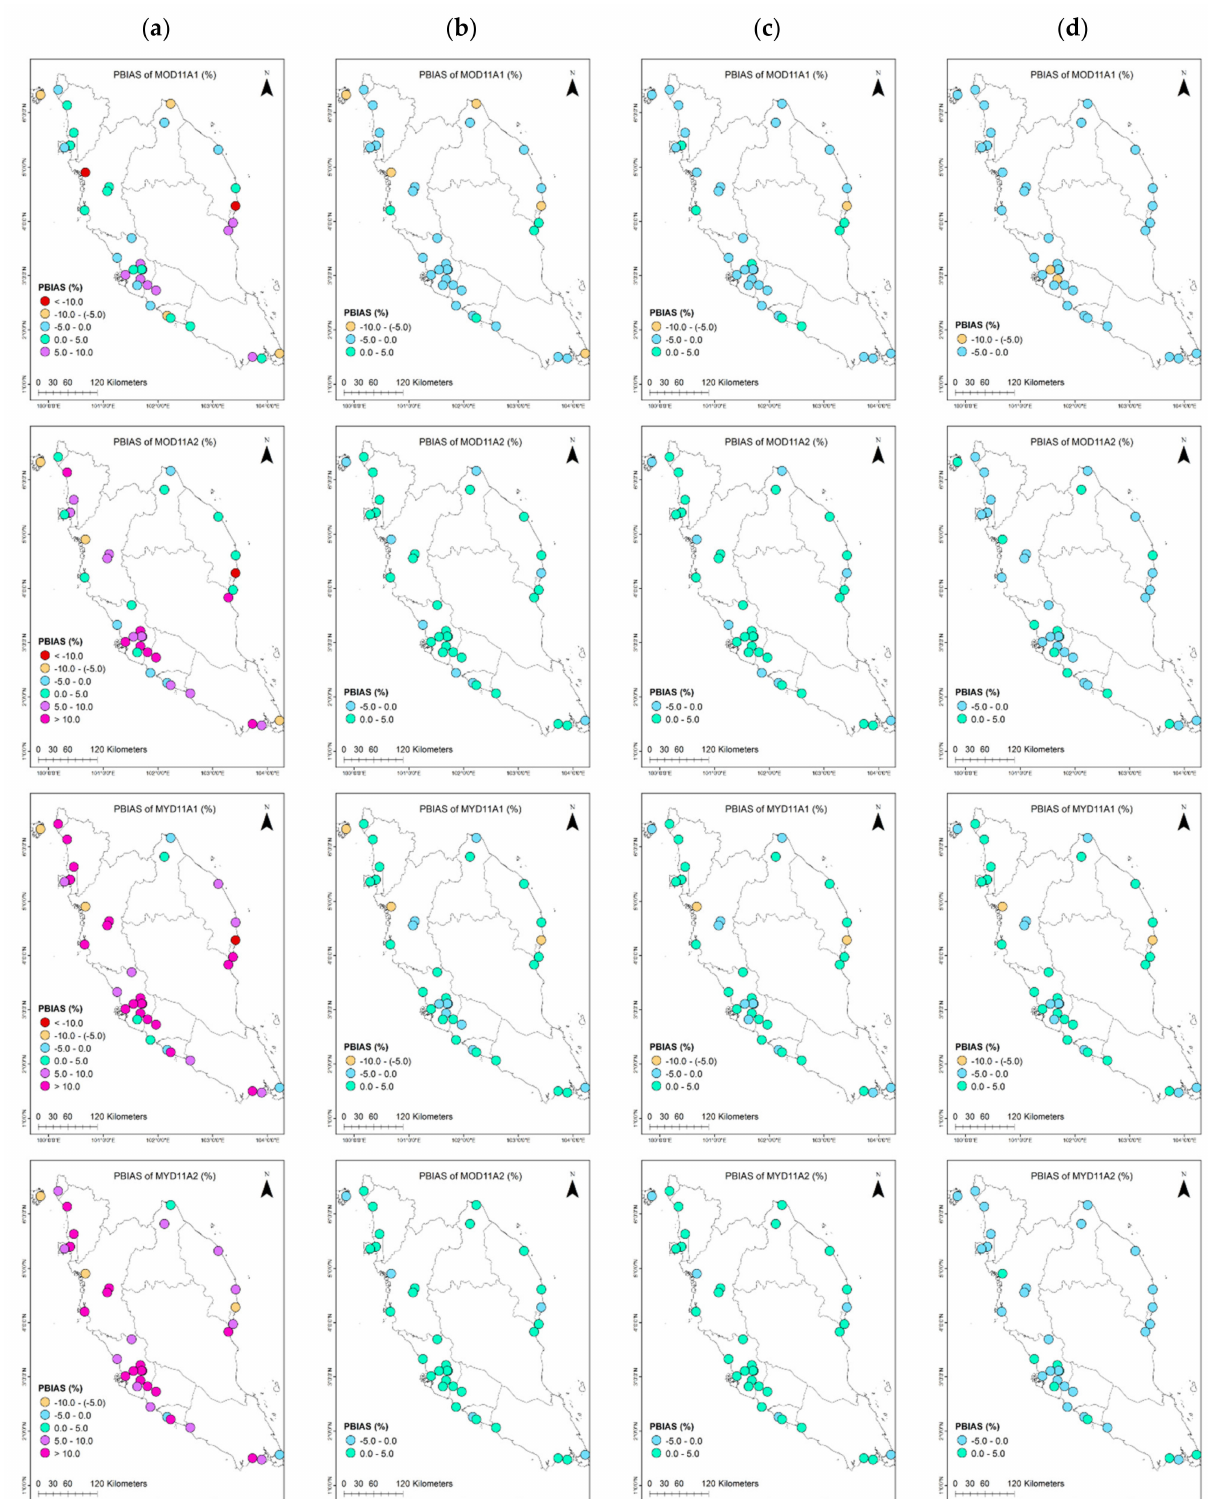
Figure 7. Distribution of PBIAS for comparison between simulated data, ( a ) T s , ( b ) T scd , ( c ) T scm , and ( d ) T scq , and observed data, T a